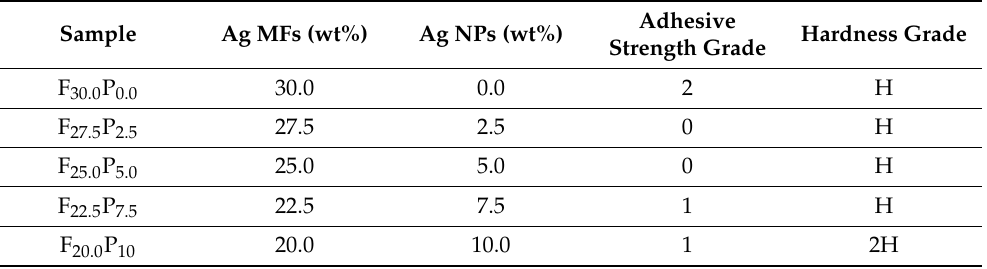
Table 2. Hardness and adhesive strength of silver paste paint films containing different Ag MFs and Ag NPs amounts after curing at 60 ◦